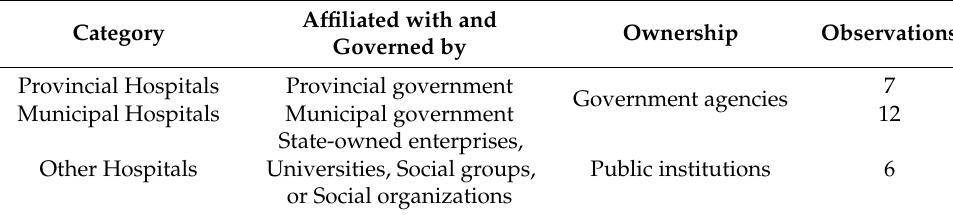
Table 1. Category of public hospitals based on differences in administrative subordination in WH.